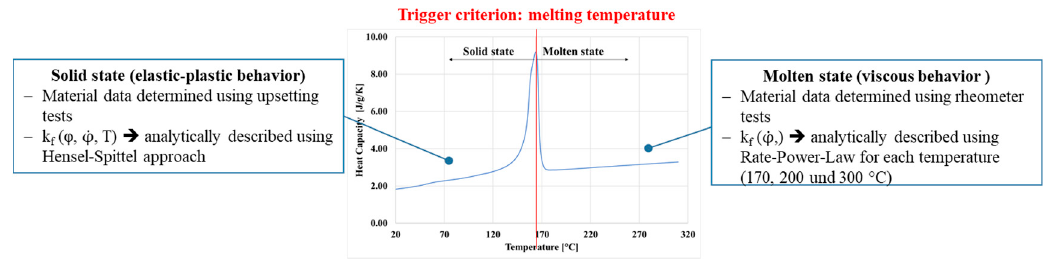
Figure 8. Basic concept of the subroutine for case distinction and material assignment .